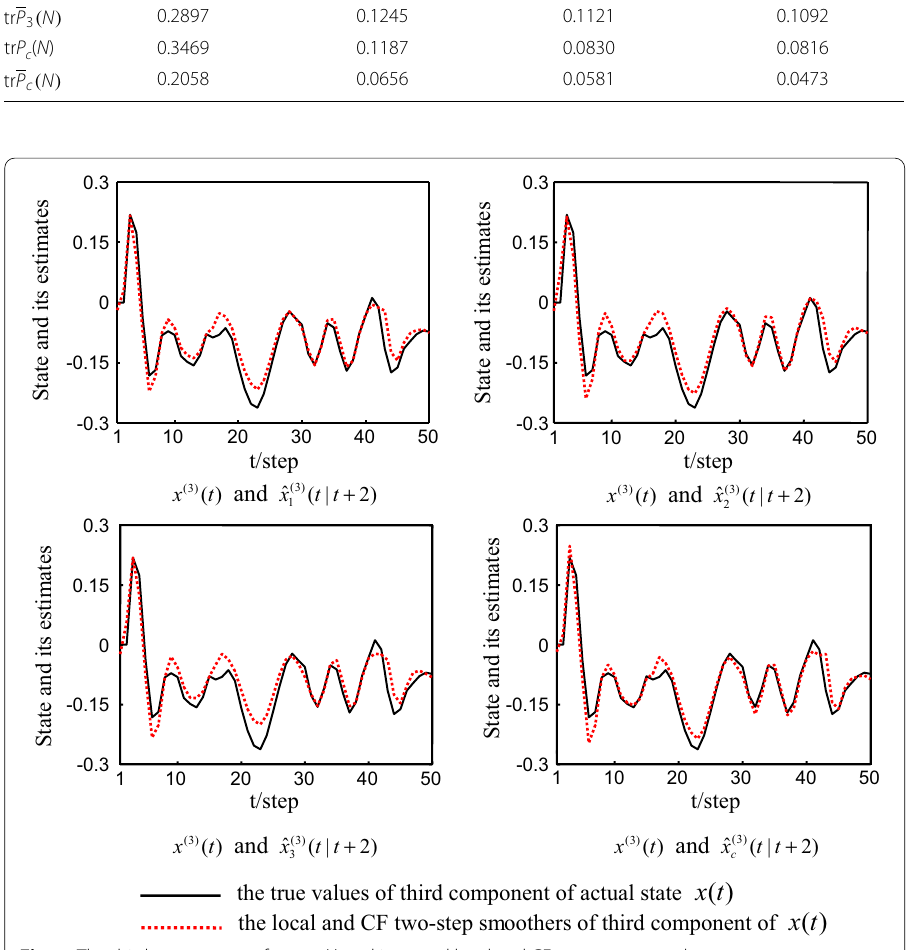
Fig. 1 The third component of state x ( t ) and its actual local and CF two-step